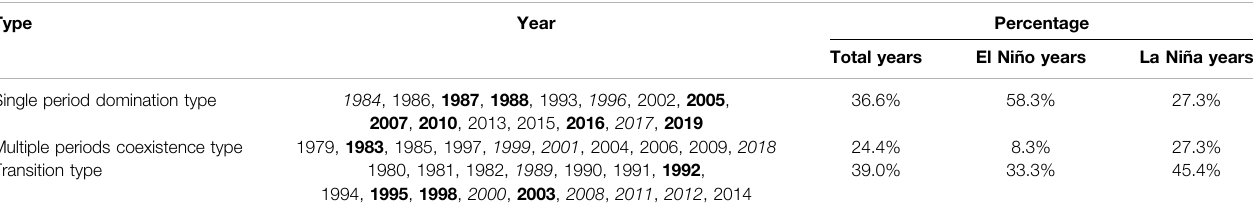
The years in Bold (italics) represent the El Niño (La Niña) year.